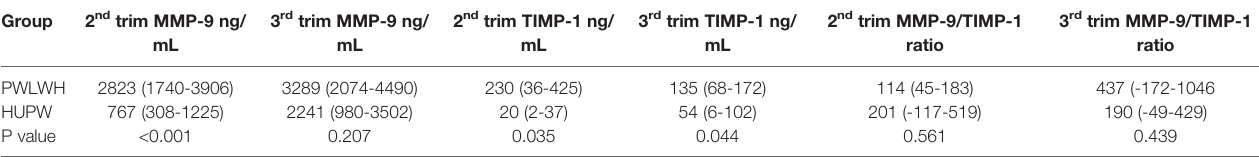
TABLE 2 | Mean MMP-9, TIMP-1 and MMP-9/TIMP-1 ratio in second and third trimesters by HIV status.